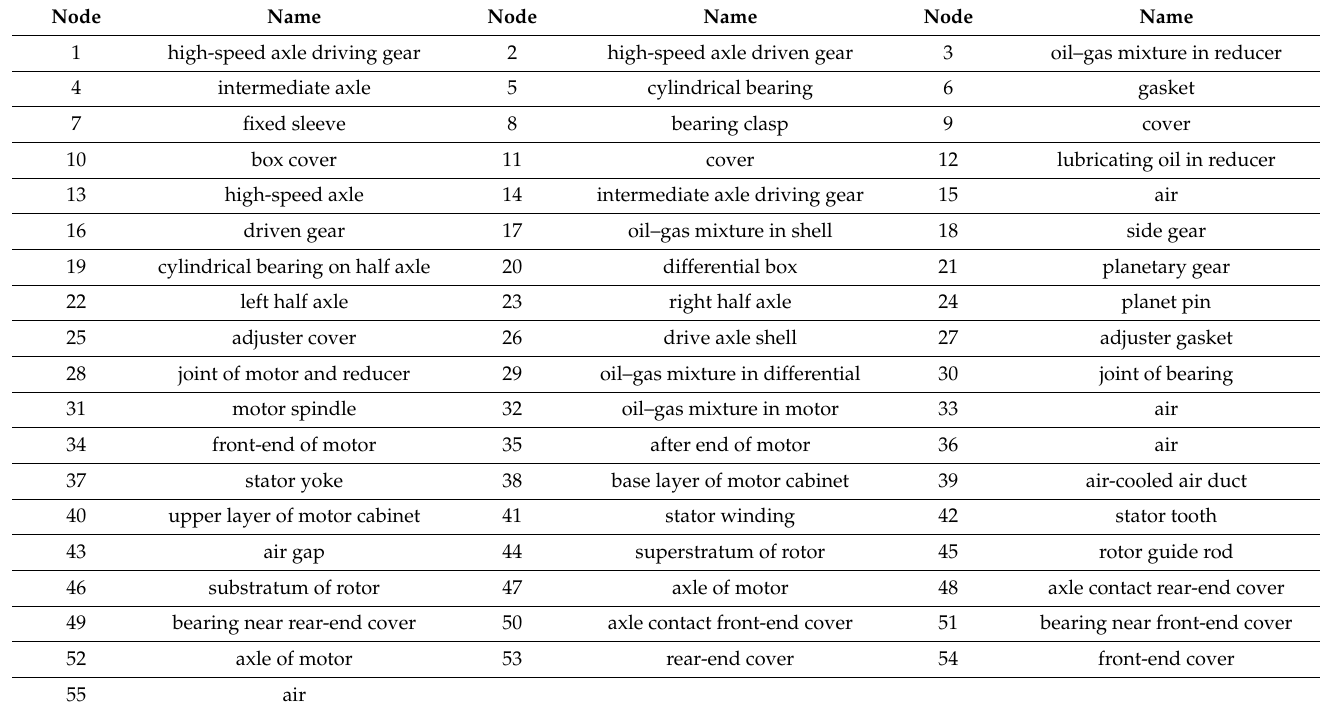
Table 1. Fifty-five nodes in the thermal network